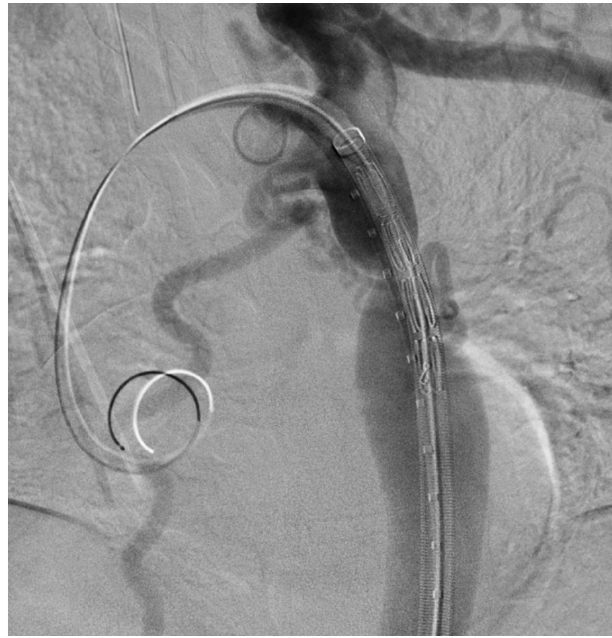
Fig. 3 – Dominus ® Coarctation Aorta delivery system advanced retrogradely until the tip of the sheath is slightly beyond the coarctation